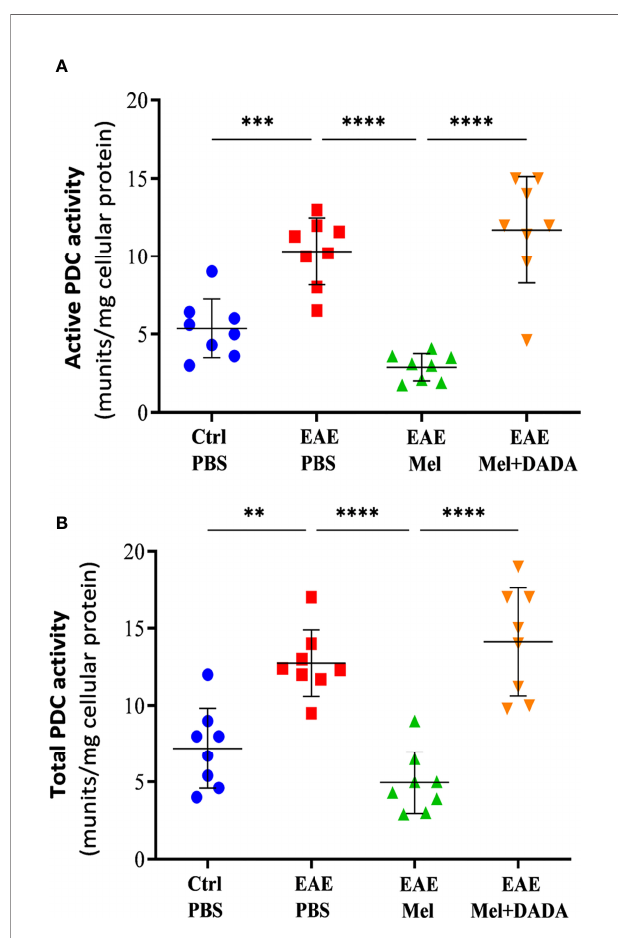
FIGURE 7 | Activity of PDC. The change in the activity of PDC enzyme was measured either at the (A) “ active ” or (B) “ total ” forms of PDC. Values are expressed as the Mean ± SEM. Each group included 8 mice (n = 8). Statistical analysis was performed by one-way analysis of variance (ANOVA) followed by Tukey ’ s test. Signi fi cance is indicated by **p < 0.01; ***p < 0.001 and ****p <